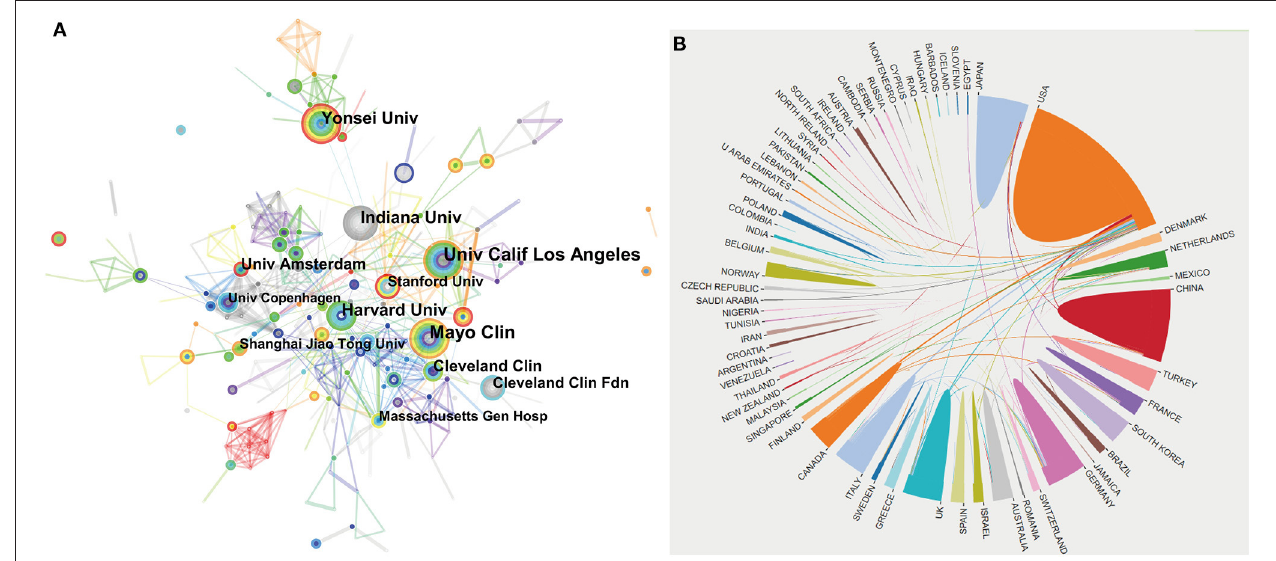
FIGURE 3 | The network map of institutions involved in Endoscopic Sedation research (A) and collaboration between countries/regions (B) .